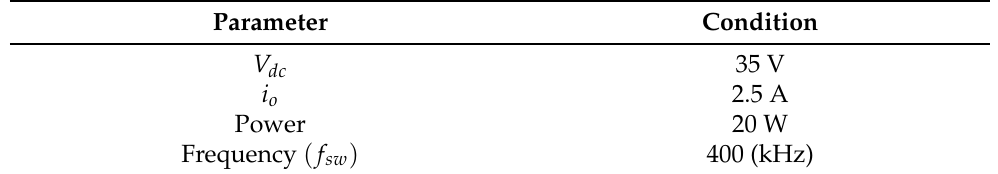
Table 4. Test condition to evaluate efficiency, η [21].